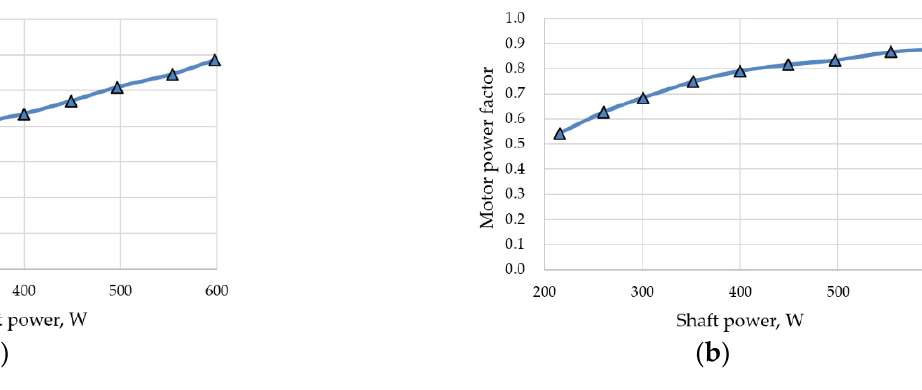
( b ) Figure 6. Experimental results: ( a ) comparison of total loss by the input-output method and the proposed indirect method; ( b ) separate losses evaluated using the indirect method. Figure 7. Comparison of motor efficiency measured by the input-output method and the proposed indirect method. Based on the results of comparing the total loss and efficiency obtained by the direct and indirect methods, it can be concluded that they coincide with great accuracy. If the measurements carried out by the direct method are considered correct (which is guaran- teed by the selection of measuring instruments and test procedures in accordance with [15]), then this means that the proposed simple indirect method, under the assumptions